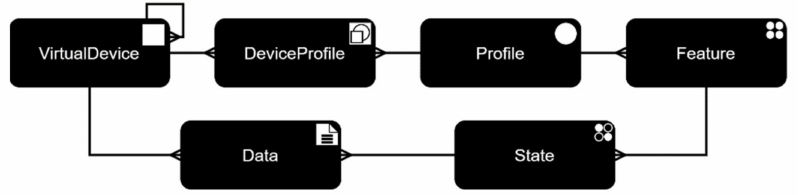
Figure 2. Data model proposed for the IoT mulsemedia prototyping software. It is formed by many associations involving virtual devices (representing real equipment), profiles (or capabili- ties descriptors) grouping features and states, and data for handling timestamped action requests (e.g., turn on a lamp, set display to reproduce a video) to virtual devices.